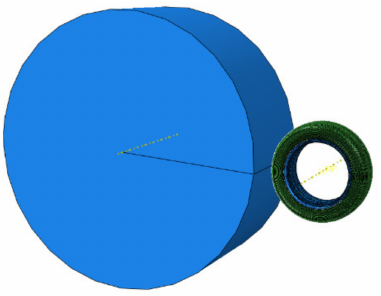
Figure 3. FEM of a rotating tire and driving drum.